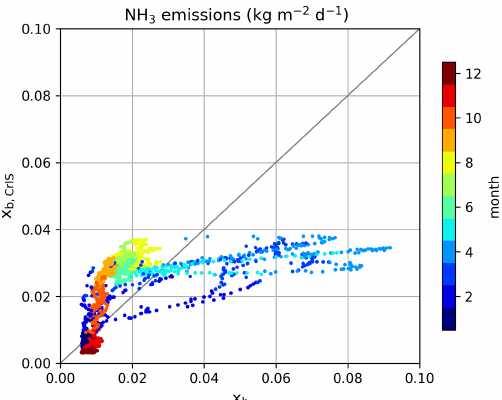
Figure 3. Daily grid-averaged NH 3 emission, colored per month. Here, x b represents the default background run and x b , CrIS the background run with CrIS-based NH 3 time